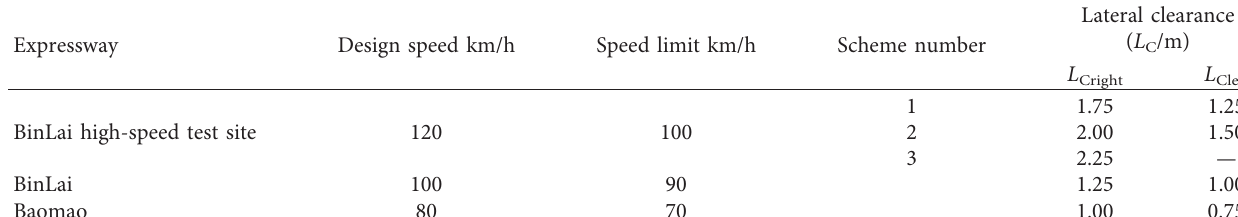
Table 2: Tunnel lateral clearance marking scheme.